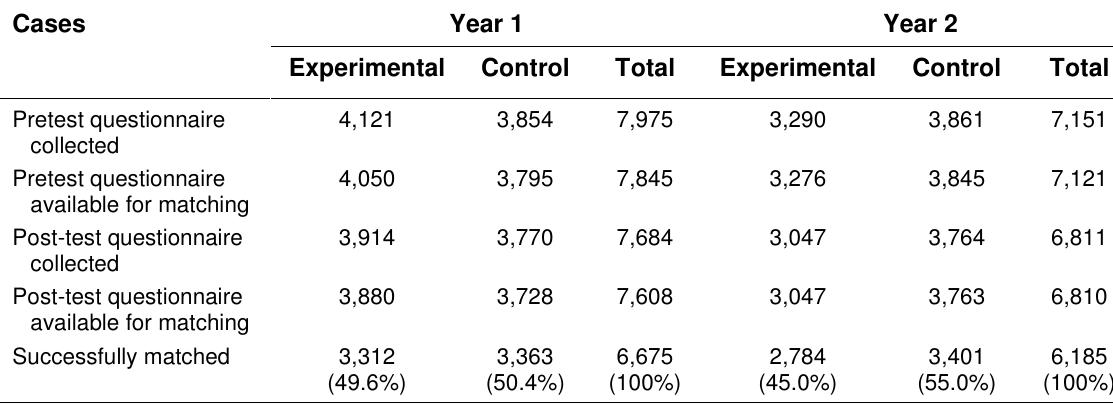
Number of Participants and Completed Questionnaires Collected at Year 1 (Waves 1 and 2)